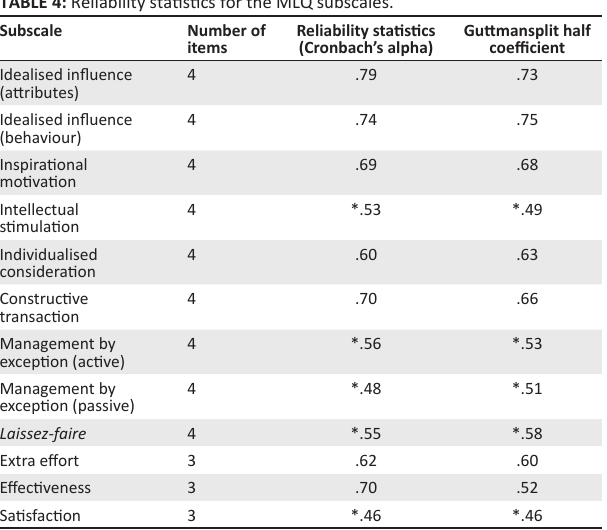
TABLE 4: Reliability statistics for the MLQ